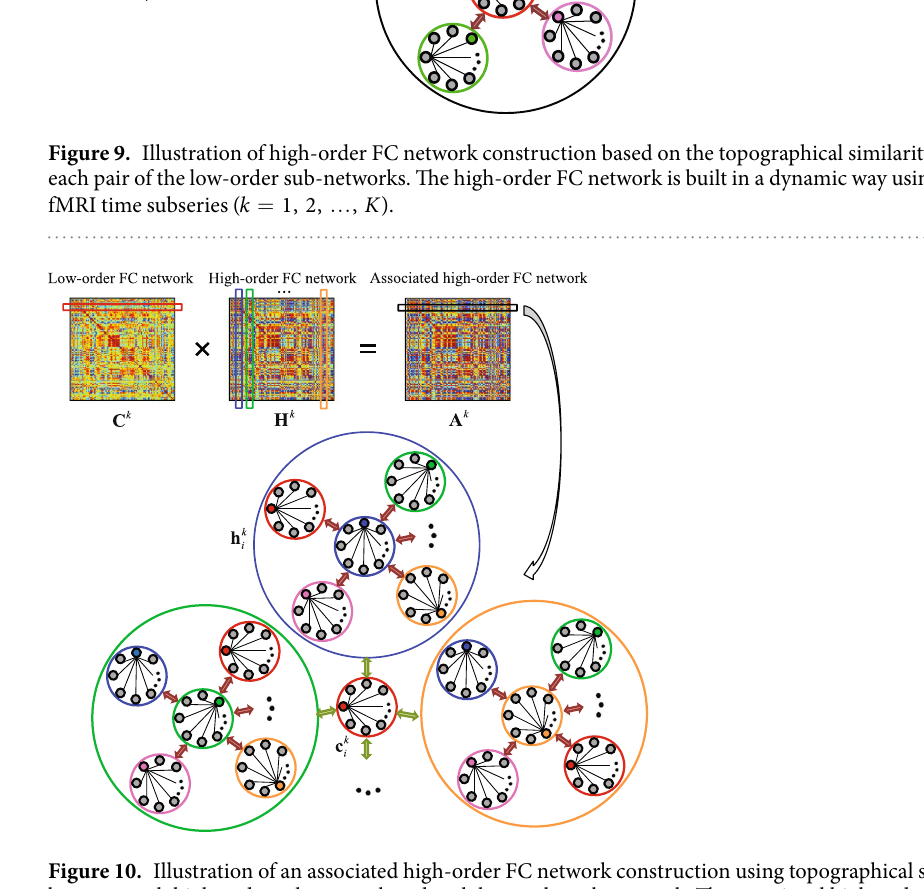
Figure 10. Illustration of an associated high-order FC network construction using topographical similarity between each high-order sub-network and each low-order sub-network. The associated high-order FC network is built in a dynamic way using the k -th rs-fMRI time